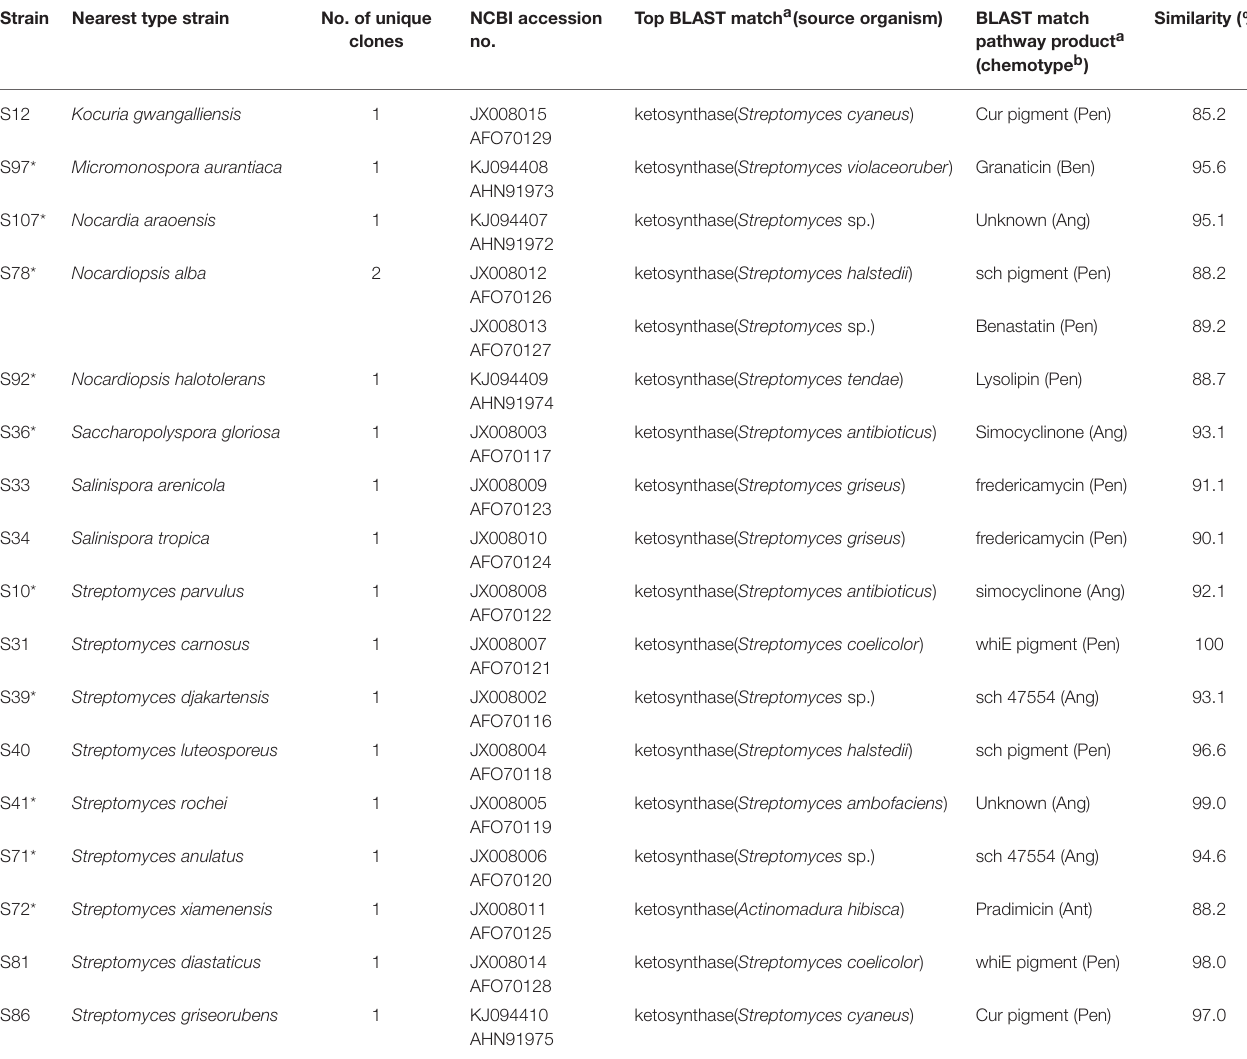
TABLE 3 | KS α amino acid